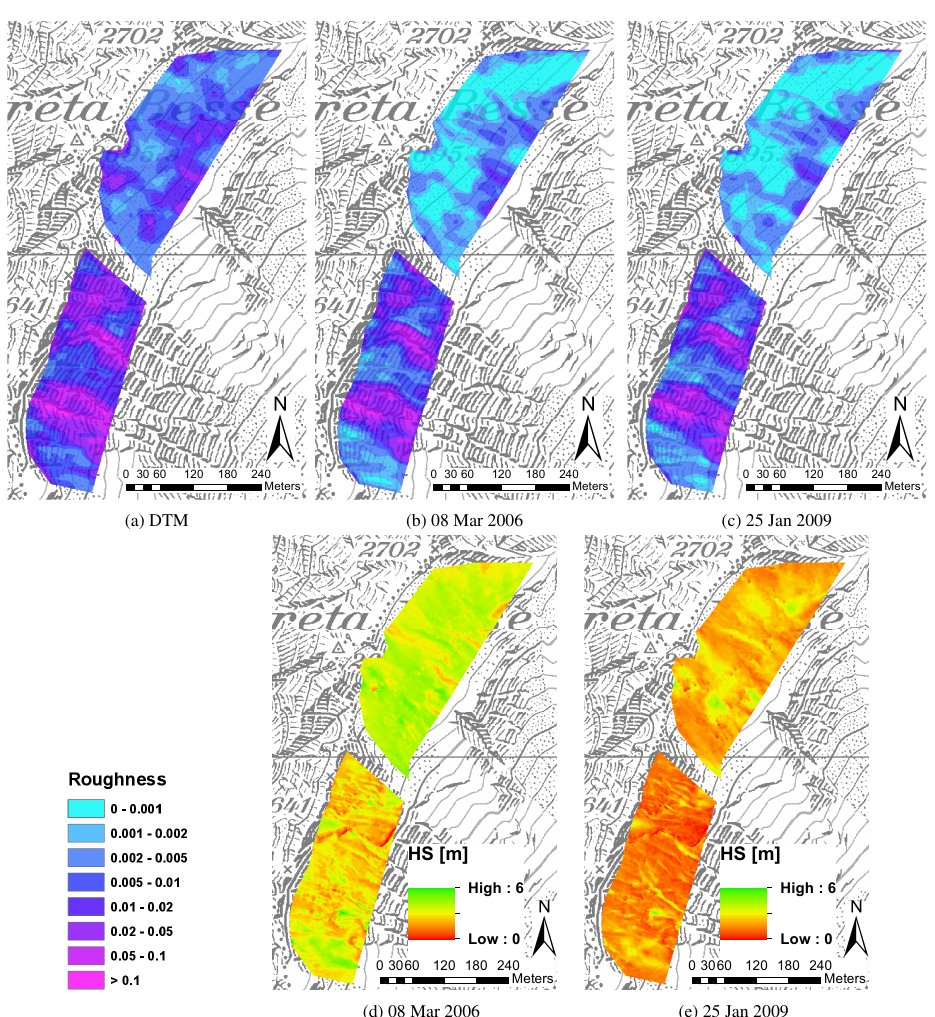
Fig. 12. (a) Surface roughness of summer terrain and (b, c) winter terrain at a scale of 25m in the basins CB1 and CB2. (d, e) show the Fig. 12: (a) Surface roughness of summer terrain and (b) , (c) winter terrain at a scale of 25m in the basins CB1 and CB2. (d) , corresponding snow depth distributions. Pixmaps © 2013 swisstopo (5704 000 000). (e) show the corresponding snow depth distributions. Pixmaps© 2013 swisstopo (5704 000 000). surface roughness is similar to those of the snow depth distri- bution at a scale of 5 m, it is significantly higher for the larger scales of 15 and 25 m. Even more important, winter terrain roughness is correlated to a significantly larger degree with all other winter surfaces with similar or larger snow depth than each of the winter surfaces is with the terrain. For exam- ple, at a scale of 5 m in ST, an increase of R 2 between 0.09 and 0.16 for all winter surfaces is observed using the win- ter terrain of 10 January 2013 as a reference instead of the summer terrain. This is noteworthy as several glide cracks in winter 2011/12 introduced considerable alteration in the surfaces. At larger scales of 15 and 25 m the increase is also observed but to a slightly lesser extent. This is mainly due to the already very strong correlation with the terrain at larger scales, reducing the potential gain in